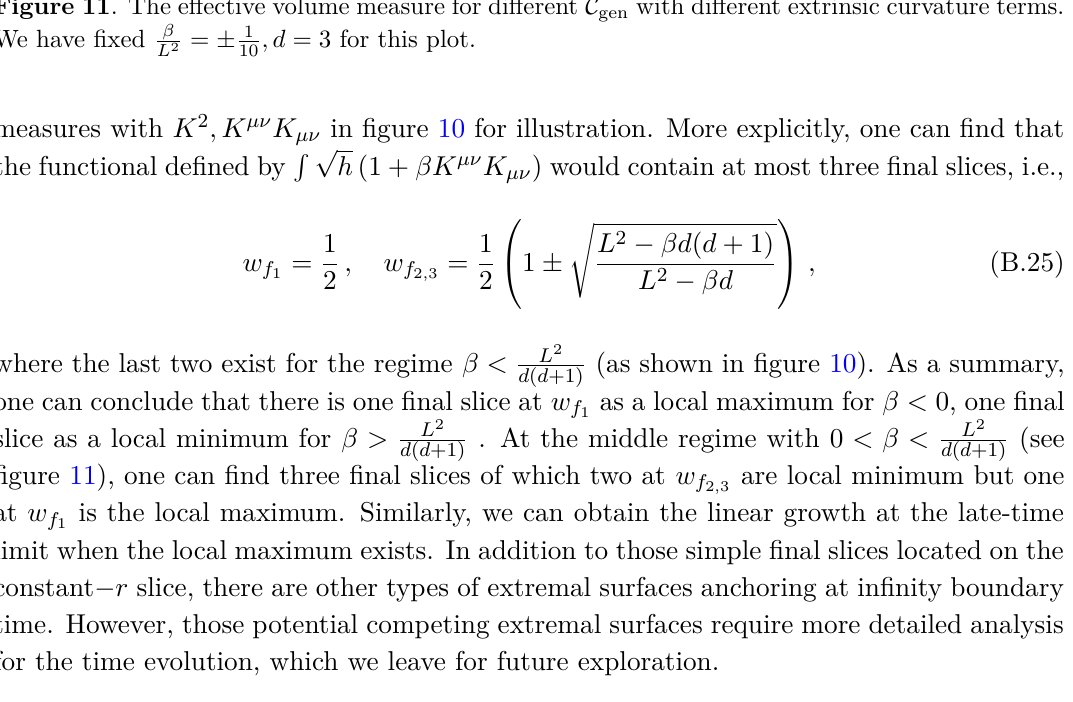
Figure 11 . The effective volume measure for different C gen with different extrinsic curvature terms. We have fixed β = ± 1 , d = 3 for this L 2 10